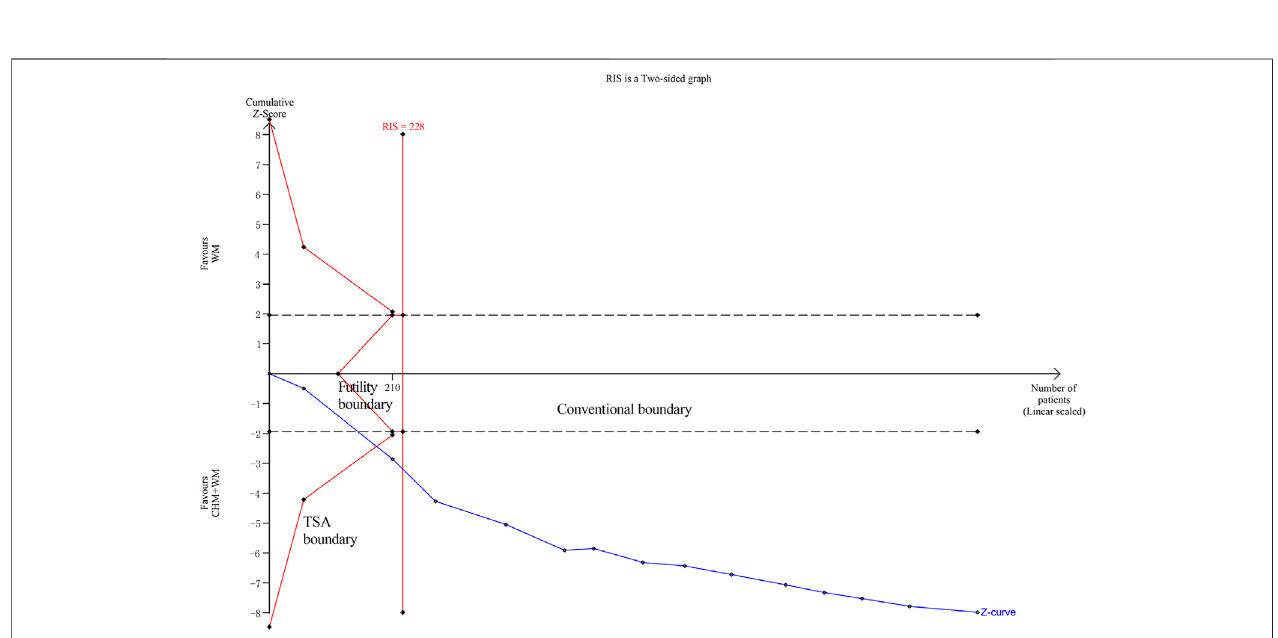
FIGURE 6 | Trial sequential analysis of clinical ef fi cacy rate.